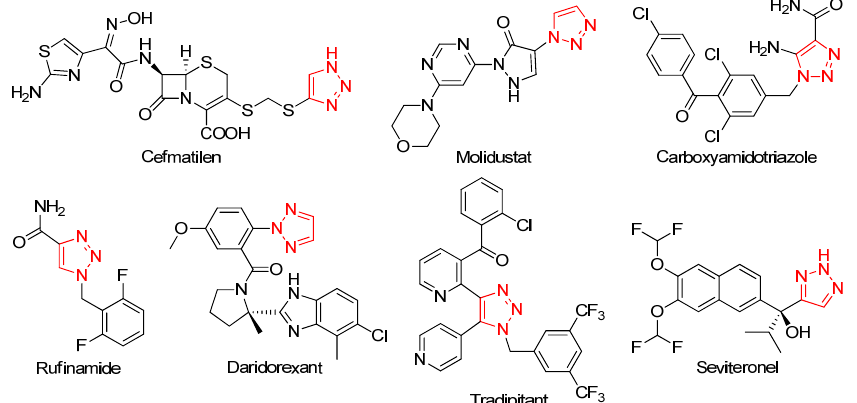
Figure 1. Selected biologically active compounds bearing triazole moieties.